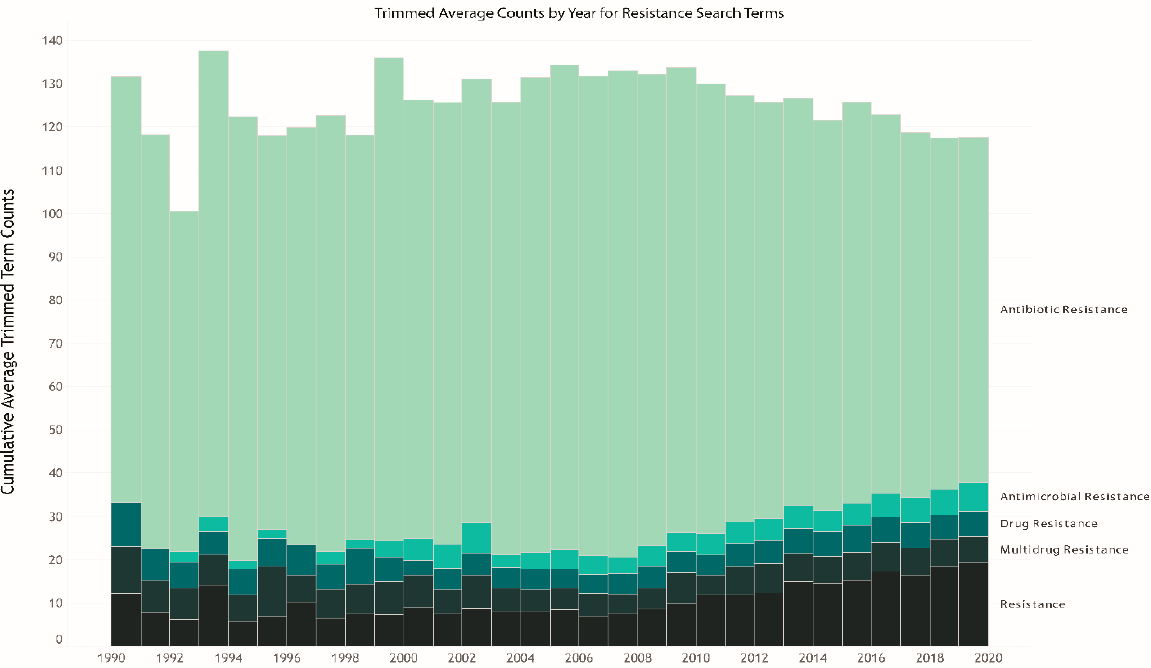
Figure 2. The average trimmed term counts of resistance-related search terms each year used per article. Trimmed search term counts, top and bottom 10%, were removed as assumed outliers.